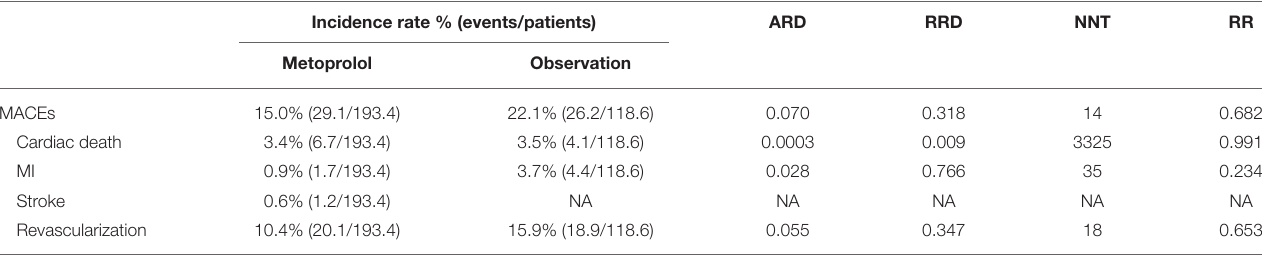
Revascularization 10.4%